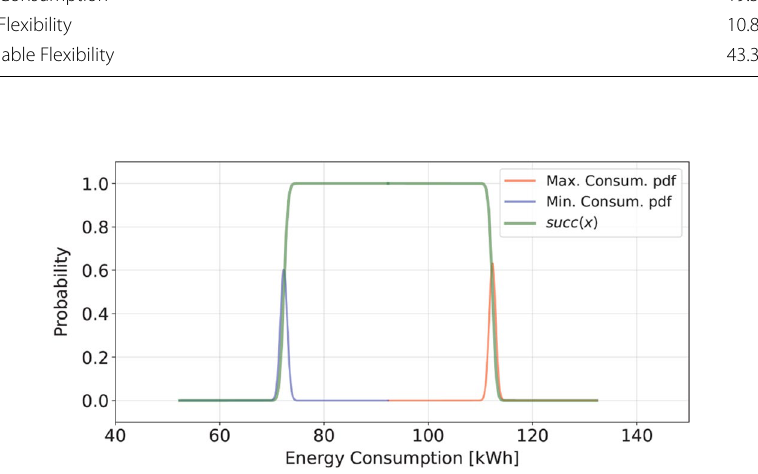
Fig. 10 Probabilistic FlexOffers computed for the proposed case